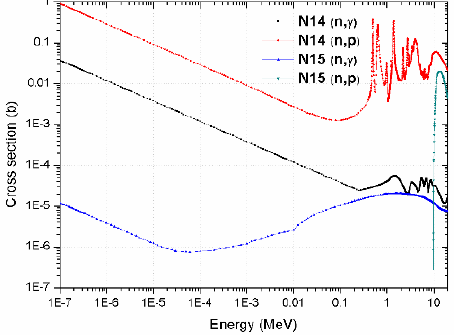
Figure 4. Comparison of N ‐ 14 and N ‐ 15 cross sections [17].